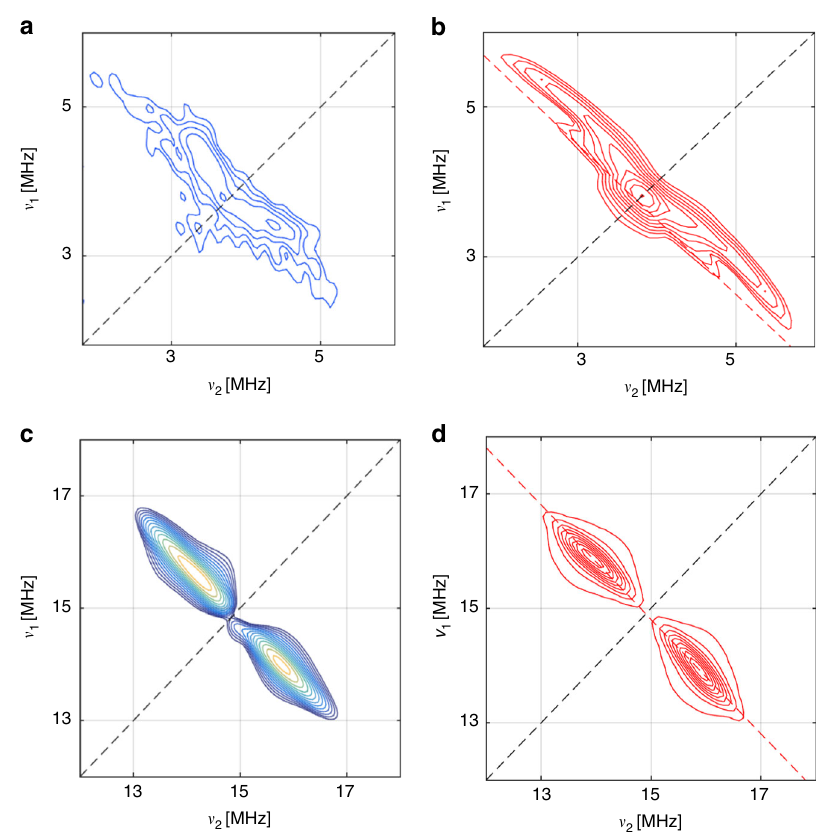
Fig. 3 Pulsed EPR studies of a frozen solution of 1 (10 mM, THF). a 13 C HYSCORE spectrum at 50 K and B 0 = 352 mT (OP3). b Simulation of the data in ( a ). c 1 H HYSCORE spectrum at 50K and OP3. d Simulation of the data in ( c ). Simulations used EasySpin 32